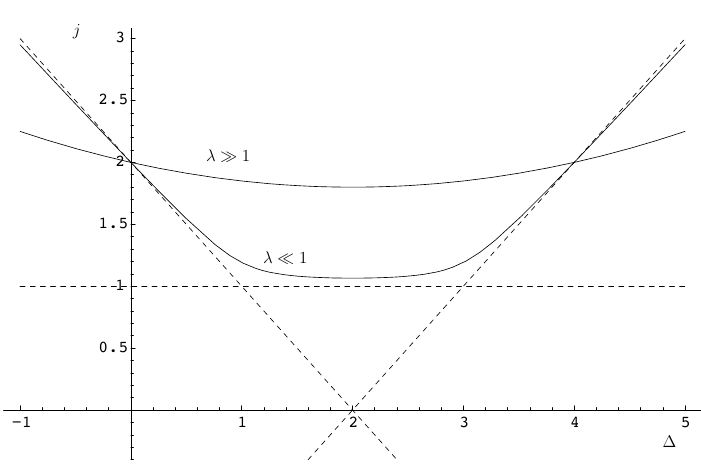
Figure 7 . Qualitative features of the leading Regge trajectory in planar gauge theory in d = 4 Figure 2: Schematic form of the ∆ j relation for λ 1 and λ 1. The dashed lines − ! " (from [50]). All trajectories pass through the point (∆ , J ) = (4 , 2) and are symmetrical under the show the λ = 0 DGLAP branch (slope 1), BFKL branch (slope 0), and inverted DGLAP shadow reflection ∆ 7→ d − ∆ . At weak coupling, the trajectory is approximatively flat in the center branch (slope 1). Note that the curves pass through the points (4,2) and (0,2) where the but bends rapidly near the intersection with the twist 2 trajectories ∆ − J ≈ 2 . At strong coupling, − anomalous dimension must vanish. This curve is often plotted in terms of ∆ j instead the curvature is small and inversely proportional to the scaling dimension ∆ higher − spin of the first − gap of ∆ , but this obscures the inversion symmetry ∆ 4 ∆ . single-trace spin-4 operator, through which the curve must pass. The horizontal axis is related to → − the transverse momentum ν of bulk excitations as ∆ = d + iν 2